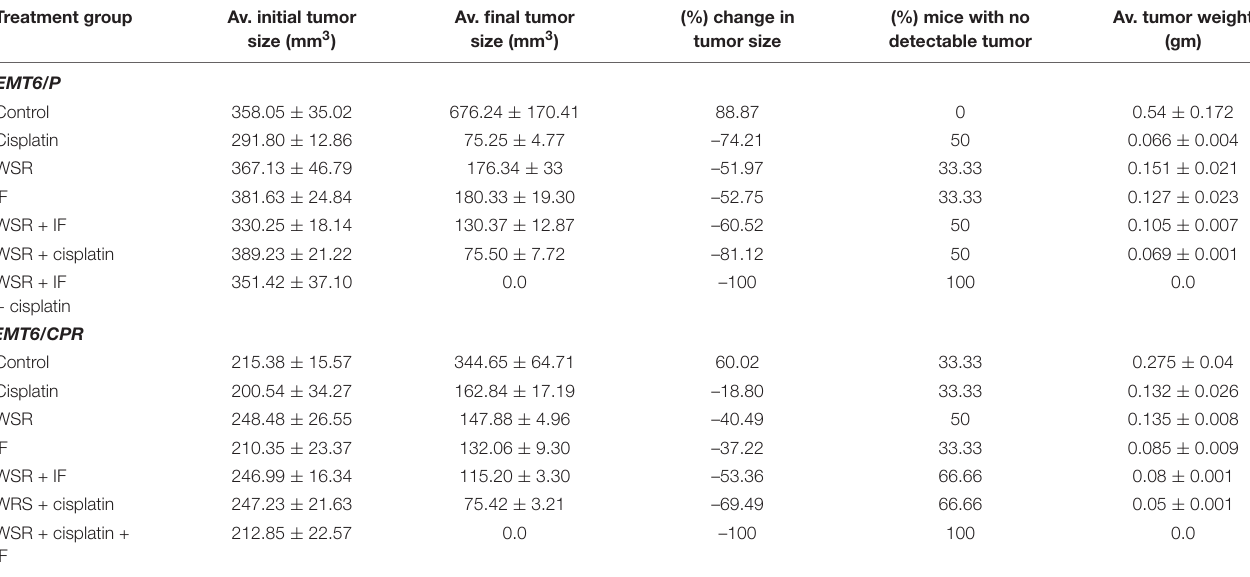
FIGURE 5 | Caspase-3 activity in breast cancer cells after treatment with WSR extract and cisplatin. (A) Treatment of EMT6/P cells with cisplatin (20 µ M), WSR extract (2.9 mg/ml), and their combination (10 µ M cisplatin with 0.54 mg/ml WSR extract). (B) Treatment of EMT6/C cells with cisplatin (54 µ M), WSR extract (3.8 mg/ml), and their combination (27 µ M cisplatin with 0.66 mg/ml WSR extract) in EMT6/C cell line. Results are expressed as means ± SEM ( n = 3). ∗ P < 0.05, ∗∗∗ P < 0.001. ( ∗ : treatments groups compared with the control group). TABLE 3 | Results of WSR extract, intermittent fasting (IF), cisplatin and their combinations concerning tumor size changes, percentage of changes in tumor size, and average tumor weight in EMT6/P and EMT6/CPR cell line. Treatment